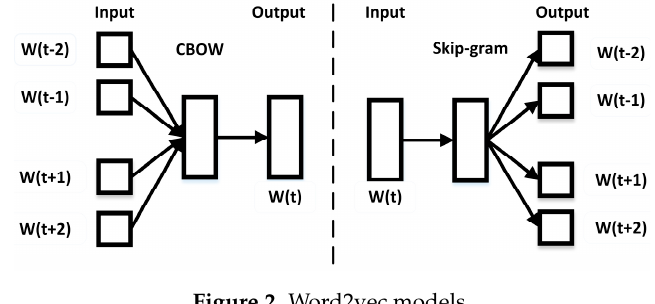
Figure 2. Word2vec models.